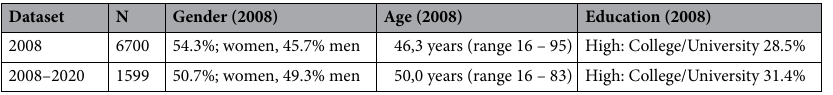
Table 5. Description of the dataset and comparison with initial sample (e.g., all respondents who answered the values questions regarding values) in T0.